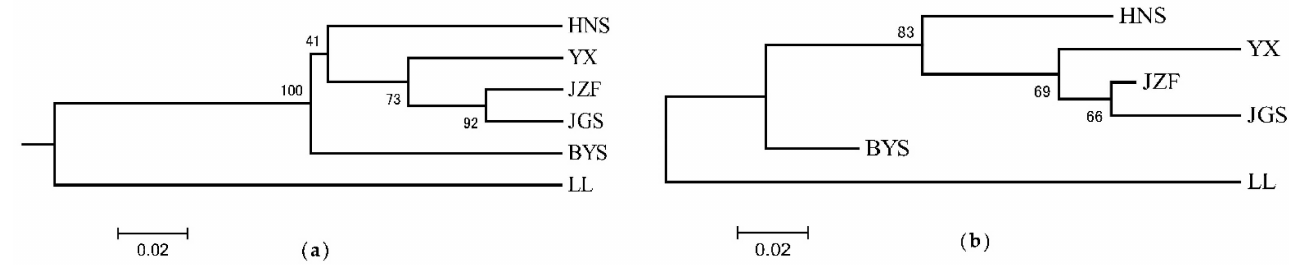
Figure 3. Phylogeny relationships among six populations of S. tzumu by unweighted pair-group method (UPGMA) ( a ) and neighbor-joining (NJ) method ( b ) based on D A